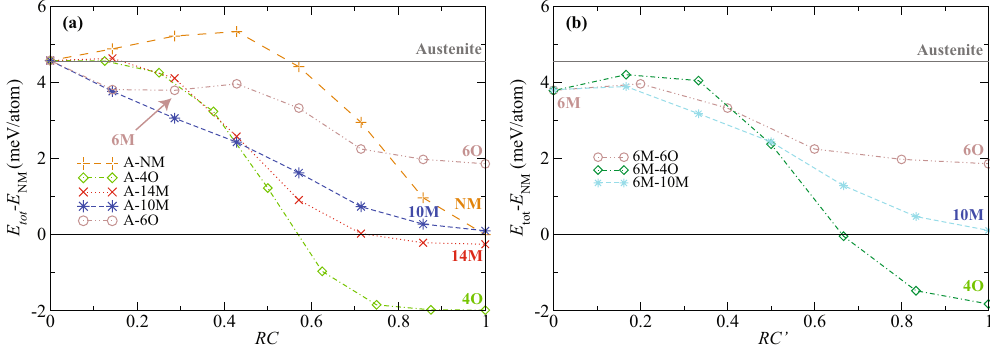
Figure 2. Calculated minimum energy path (MEP) of Ni 2 MnGa along the reaction coordinates, RC ′ and RC , for the transformation starting from austenite ( a ) and from 6M premartensite ( b ) ( RC = 0: austenite; RC ′ = 0: 6M premartensite; RC = 1, RC ′ = 1: fully transformed martensite). All energies are relative to the total energy of NM